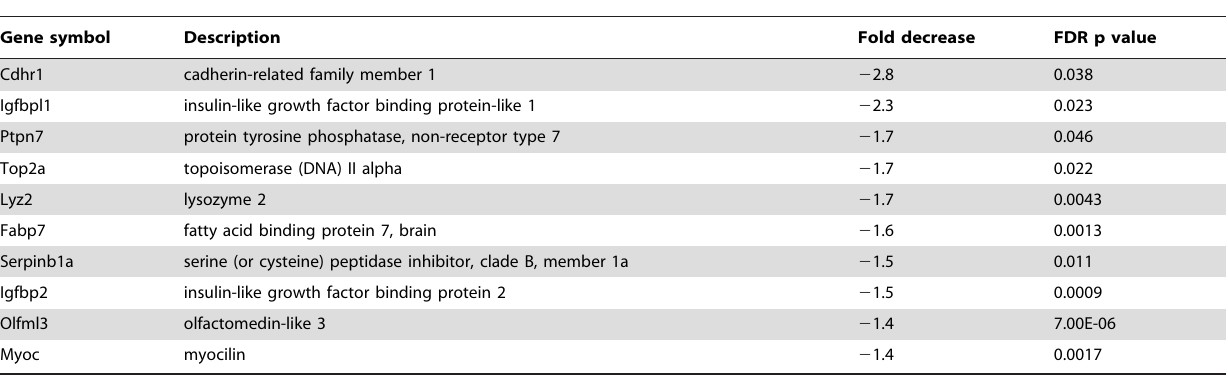
Table 2. E2-regulated genes with the most decreased expression.